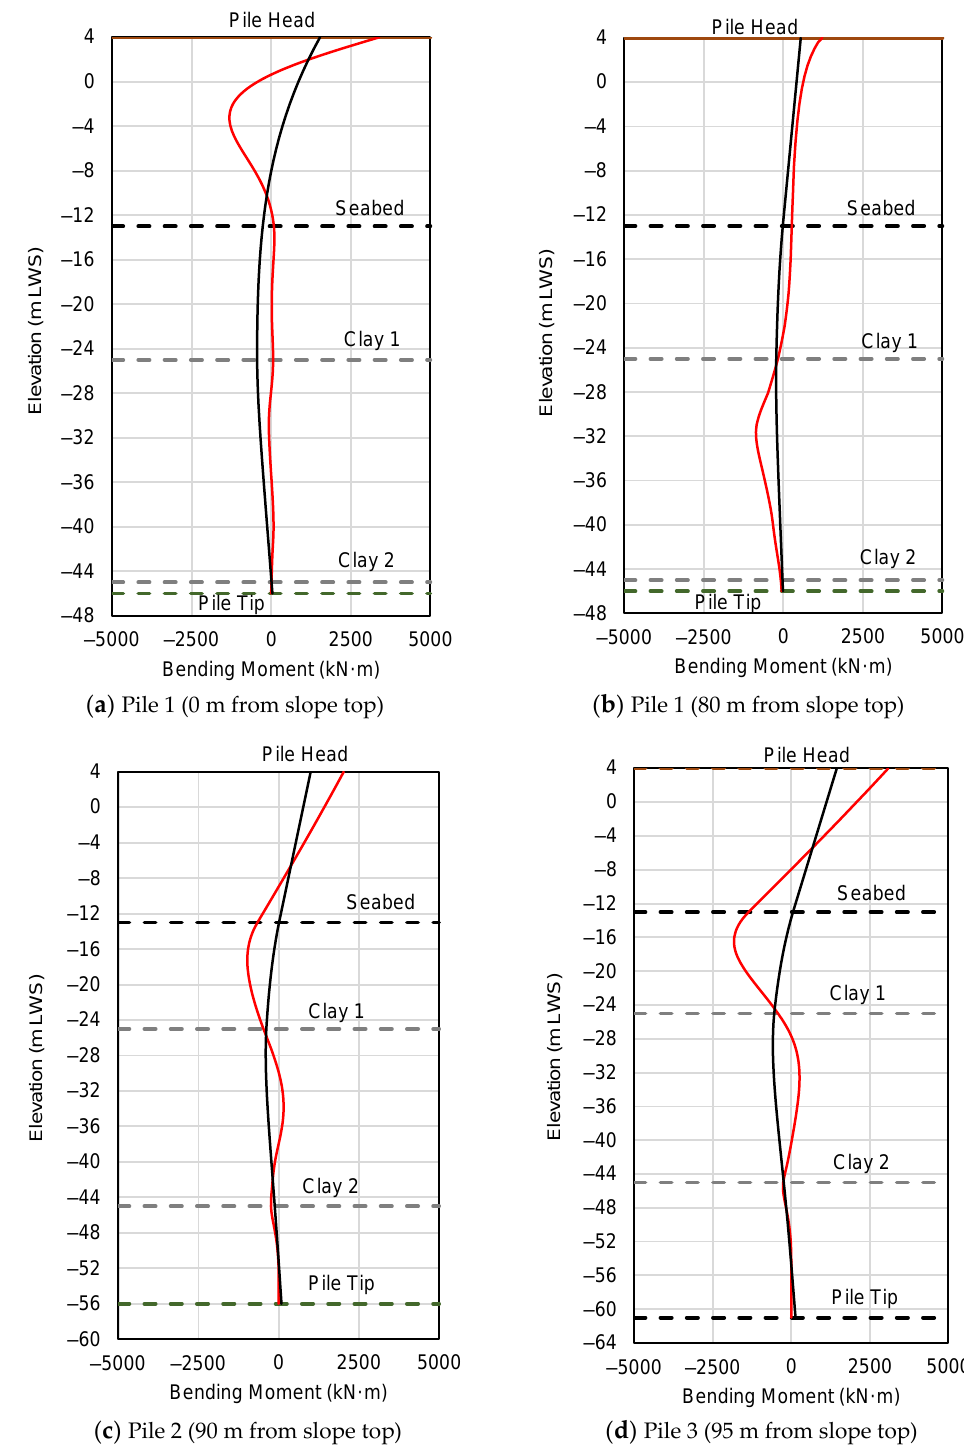
Figure 18. Bending moment distribution of the PSW considering the inertial forces due to the TE waveform (Scenario 2).